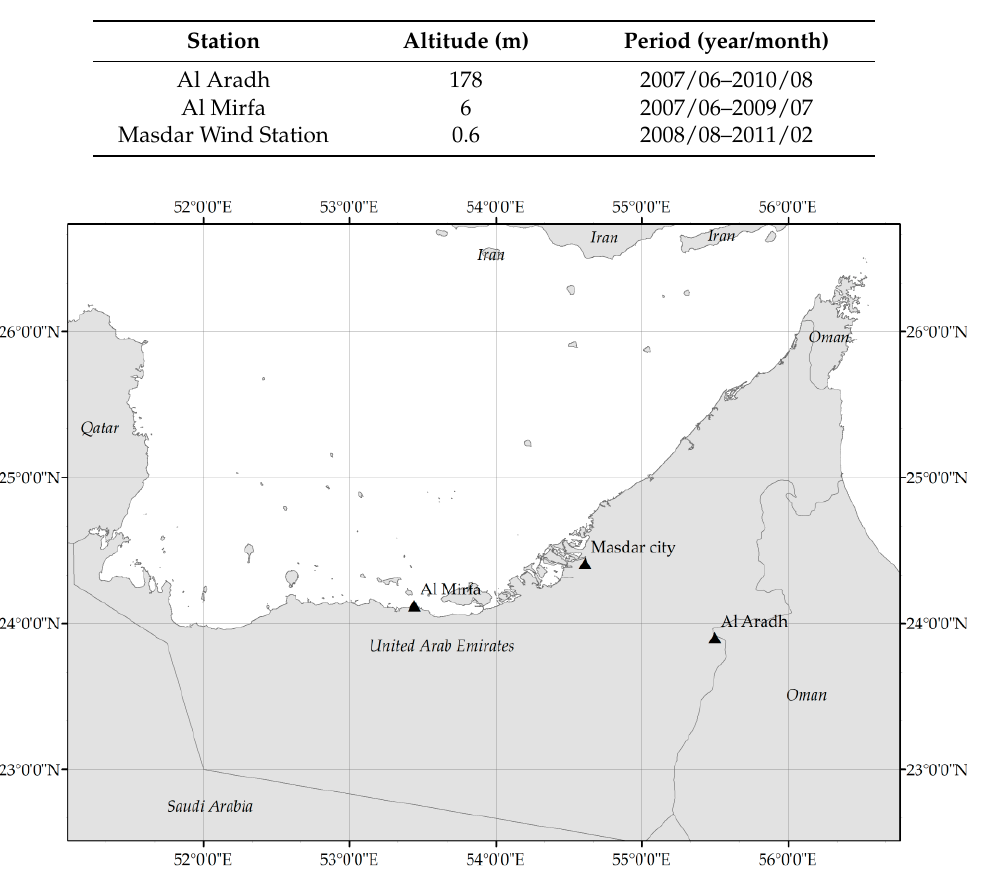
Figure 3. Geographical location of the weather stations used for 10-min mean wind speed data.